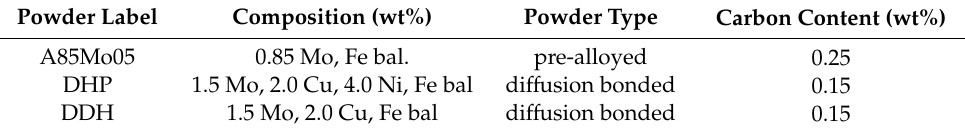
Table 2. Nominal compositions of the powders. Table taken from